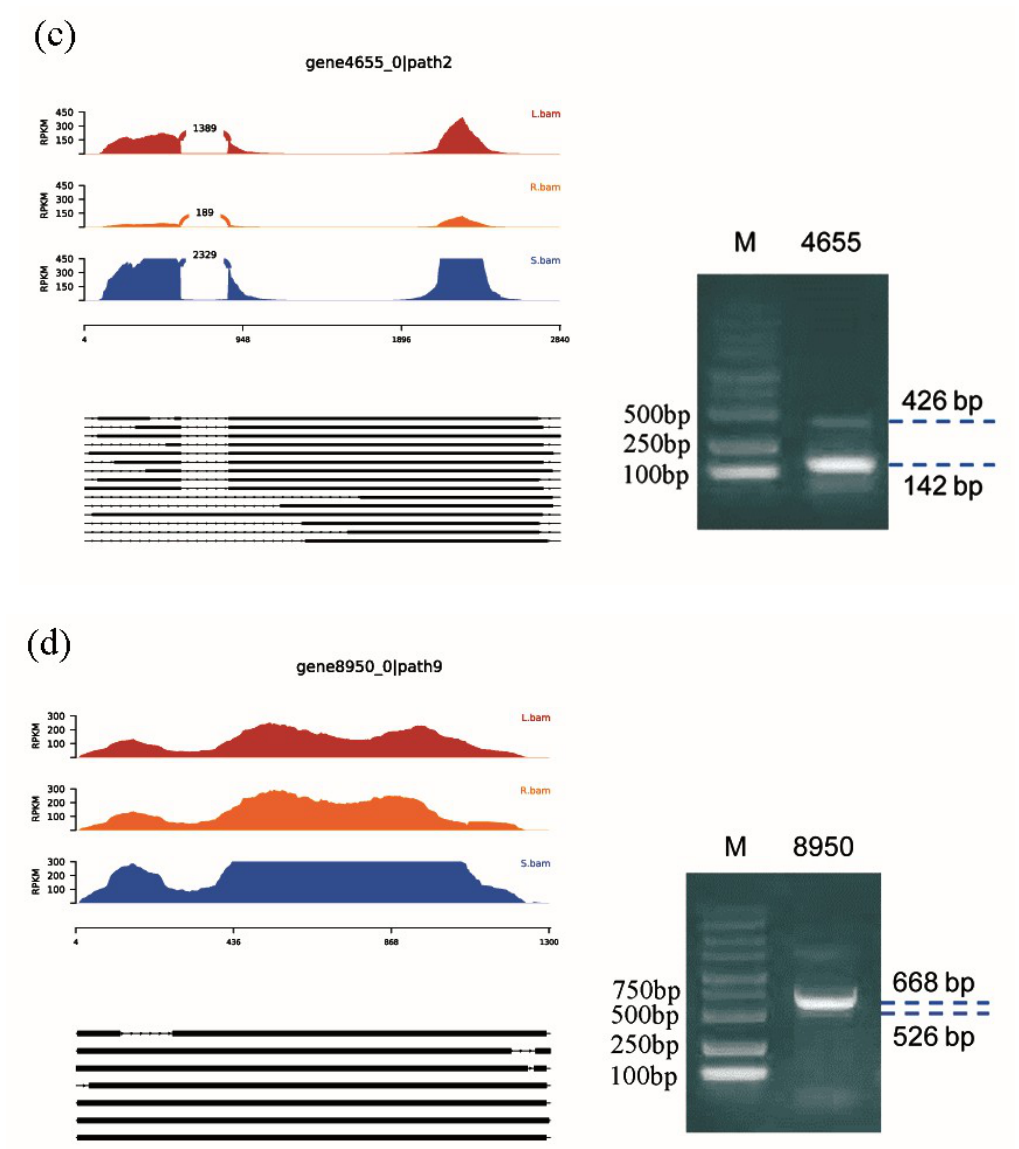
Figure 6. AS prediction and PCR validation of flavonoid biosynthesis-related key genes. ( a ) phenylalanine ammonia-lyase ( PAL ) gene 5440; ( b ) flavanone-8-hydroxylase ( F8H ) gene 7939; ( c ) PAL gene 4655; ( d ) R2R3-MYB gene 8950. Note: The alignments and coverages of Illumina reads and UniTransModels in the leaf, root, and stem are indicated in red, orange, and blue, respectively (the vertical axis represents the normalized number of supporting reads, i.e., the expression level). Below are the positional relationships between the isoform sequences obtained through PacBio sequencing and their corresponding UniTransModels (the black part indicates that at that position, the isoform was mapped to the UniTransModel, while the dashed line indicates that the isoform was not mapped to the UniTransModel). The right part displays the PCR verification results of the AS of key genes.